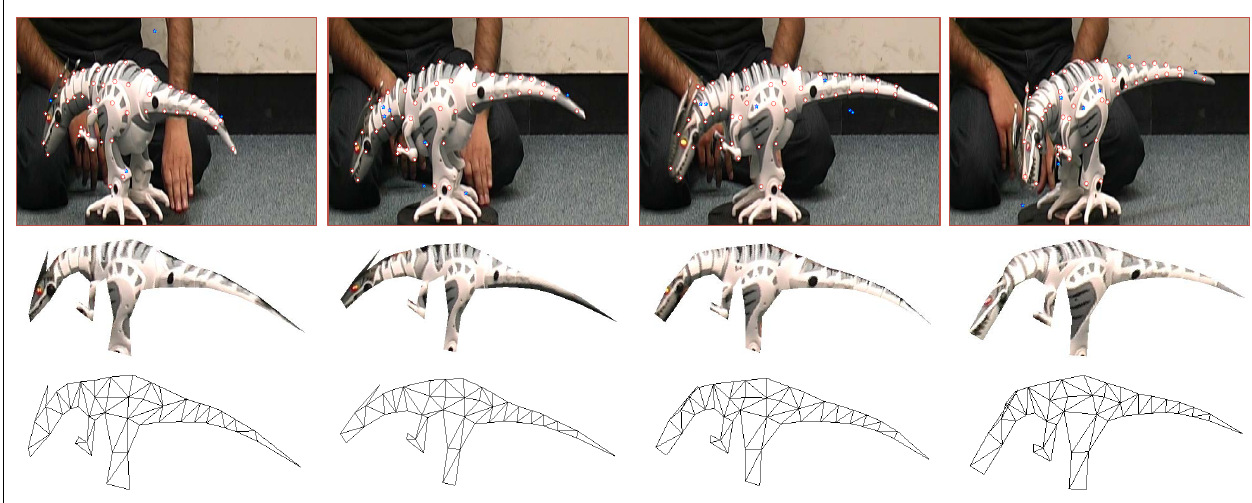
FIGURE 5 | Four frames from the dinosaur sequence, the corresponding reconstructed VRML models, and triangulated wireframes . The tracked features (red circles) and added outliers (blue stars) are superimposed to the images.